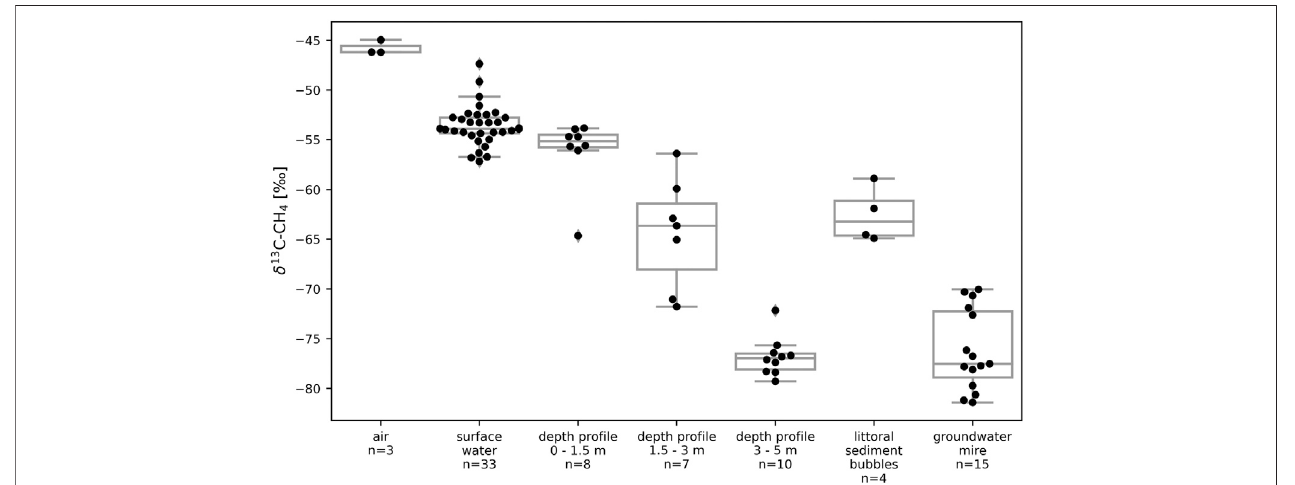
FIGURE 6 | Boxplots and individual measurements of δ 13 C-CH 4 values in the air, in lake water (surface and depth pro fi les) and littoral sediments, and in the mire groundwater in Stortjärn in August. “ Surface water ” data represents spatial variability at the surface of the lake while “ depth pro fi le ” data shows short term variability at different depths in the central part of the lake. Figure 2 shows a map with all sampling locations. Boxes extend from the lower quartile to the upper quartile. Whiskers extend to the nearest measurements within bounds corresponding to one and a half time the width of the